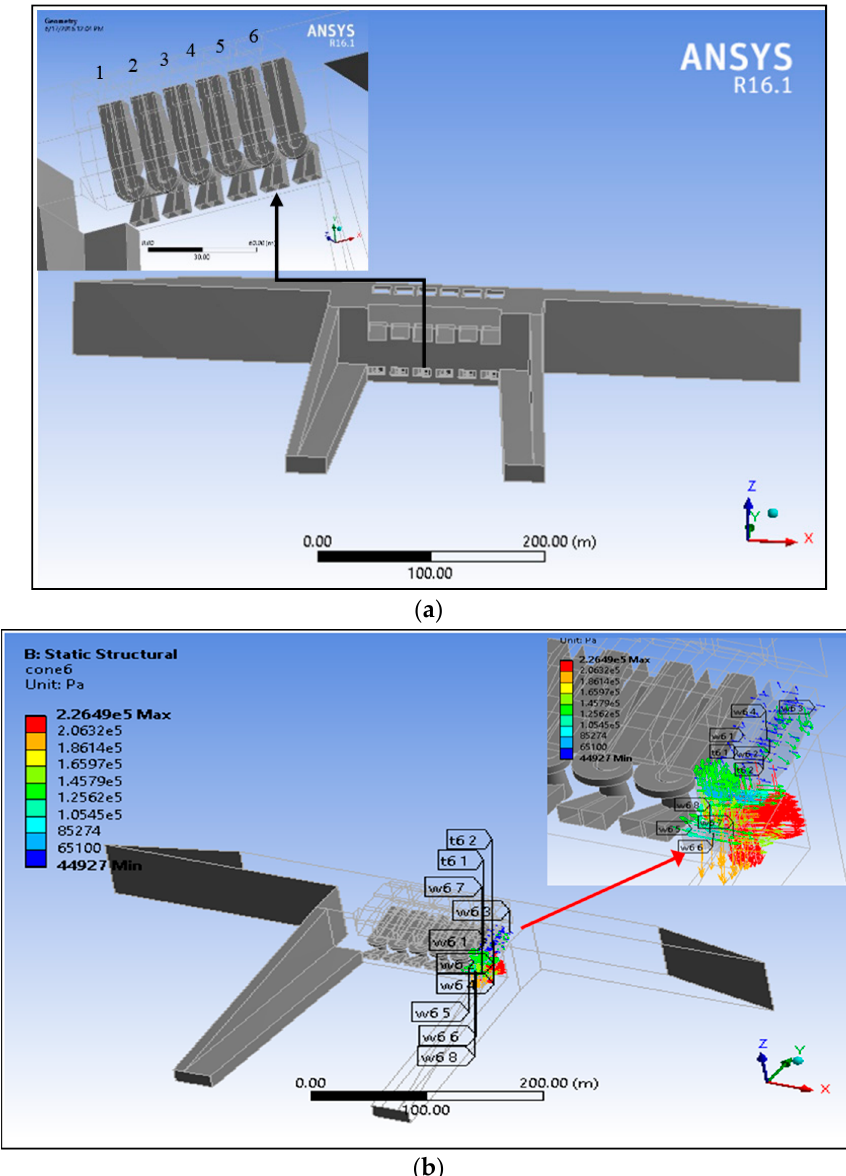
Figure 7. ( a ) The concrete part of Haditha dam with numbering the turbines and ( b ) the 3-D numerical model transforming the pressure pattern from the Haditha turbine model to the boundary of turbine unit number 6.